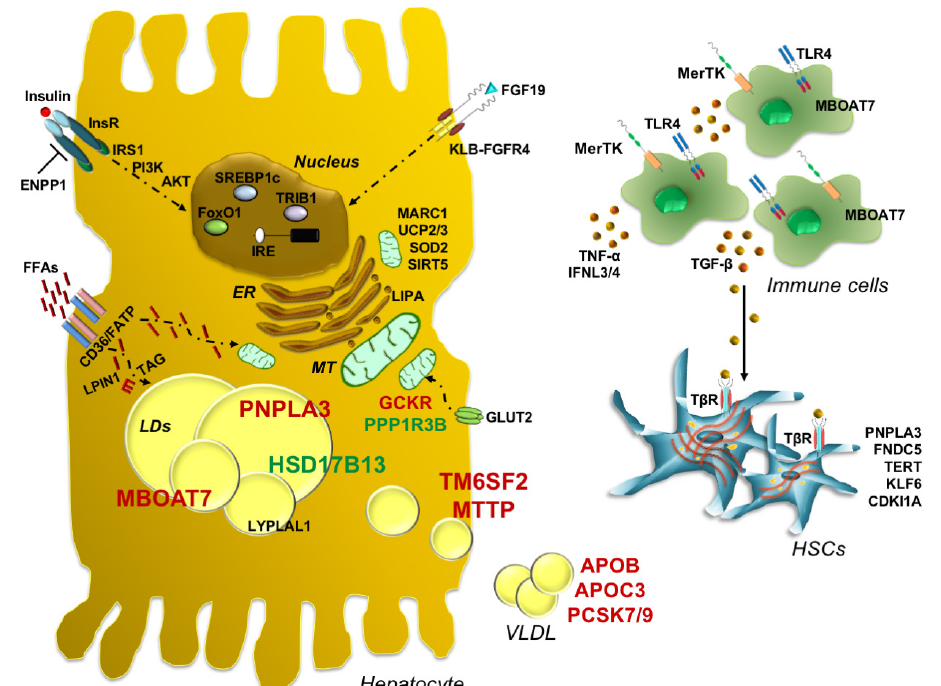
Figure 1. Genetic contribution to MAFLD pathogenesis and progression towards worsen stages. Schematic representation of the main genetic risk variants implicated in MAFLD onset and progression, which highlights their possible functional effects. PNPLA3 is an intracellular membrane lipase, localized on the surface of lipid droplets in hepatocytes where catalyzes TG hydrolysis. The PNPLA3 148M variant increases hepatic TG content upon accumulation of the mutant protein on the surface of lipid droplets, reducing TG turnover and dismissal. The I148M variant impairs the amount of released VLDL, exacerbating fat deposition. TM6SF2 is directly involved in VLDL secretion, whereas MBOAT7 catalyzes the transfers of PUFA, such as arachidonoyl-CoA to lysophospholipids, thus maintaining the fluidity of membranes. Thus, the TM6SF2 E167K variant impairs physiological VLDL secretion and affects cholesterol metabolism and TG synthesis, while the rs641738 variant in MBOAT7 reduces membrane fluidity and dynamism by altering phospholipid acyl-chains remodeling and lipogenic program in hepatocytes, while in immune cells it enhances the amount of free arachidonic acid, thus triggering inflammation. On the contrary genetic variants such as HSD17B13 and PPP1R3B may exert a protective effect against liver injuries. Furthermore, inherited variations that influence glucose and insulin signaling, FFA uptake, fat deposition and VLDL assembly and release may contribute to fatty liver development. Viceversa , hyperinsulinemia and elevated FFAs derived from adipose tissue exacerbate fat deposition induced by genetic modifiers, even activating de novo lipogenesis, through SREBP-1c. Common polymorphisms in genes regulating mitochondrial (MT) function have been associated with MAFLD development and to its progressive forms, further corroborating the switching from simple steatosis to NASH and fibrosis. In addition, it has been reported that genetic variants involved in the regulation of inflammatory response in immune cells and in the activation of HSCs to myofibroblasts phenotype may precipitate fatty liver to worsen conditions. Finally, the combined effect of PNPLA3 , TM6SF2 , and MBOAT7 genetic variants may predispose to an increased risk of progressive